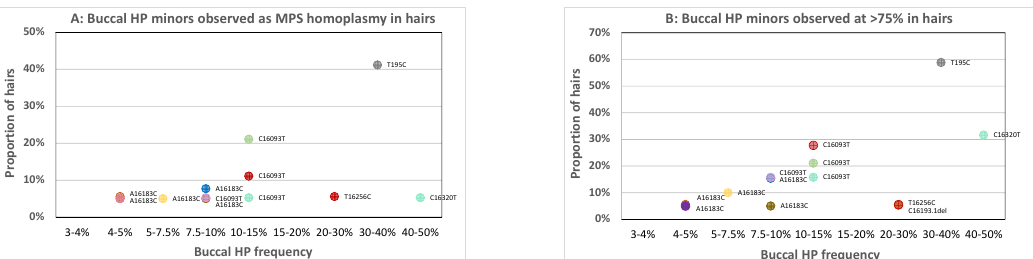
Figure 3. Proportion of hairs for which the minor HP variant of the corresponding buccal was observed as ( A ) an MPS homoplasmic variant or ( B ) approached homoplasmy (with a contribution of > 75%). Di ff erent colours represent HP sites from di ff erent individuals. Sites that did not reach MPS homoplasmy or 75% are not plotted since the majority of dots would overlap. The sites involved are displayed next to the dot depicted as the buccal major nt followed by the position and the major nt observed in the plotted